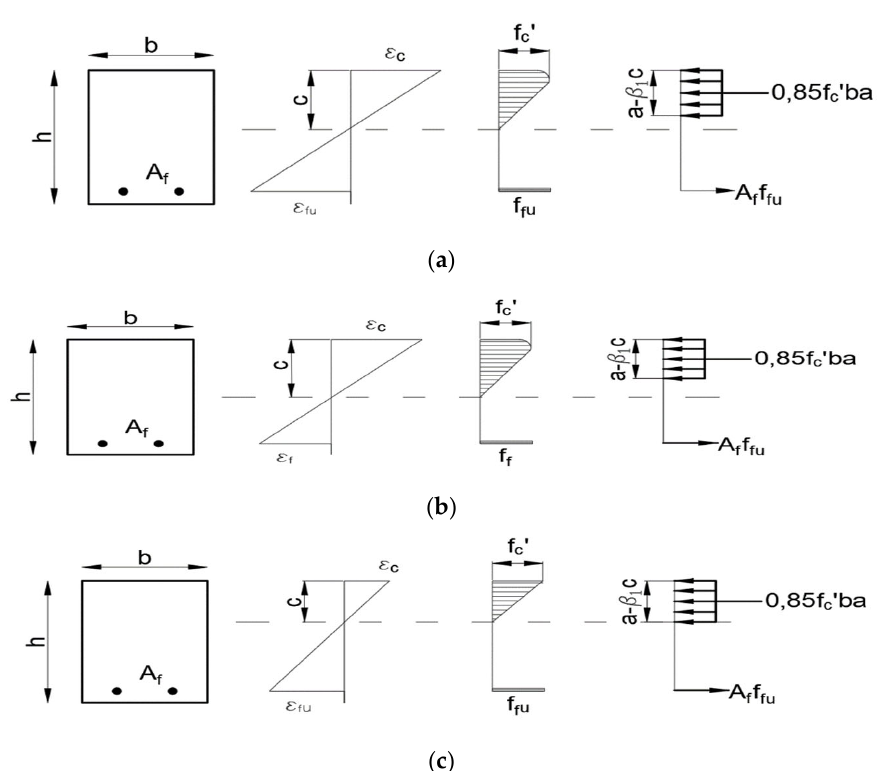
Figure 7. Three operating states of the structure with BFRP reinforcement: ( a ) cross section with the optimal degree of reinforcement, ( b ) rearmed cross section—failure by the crushing of concrete, ( c ) underreinforced cross section—failure by bars breaking. ( c ) underreinforced cross section—failure by bars